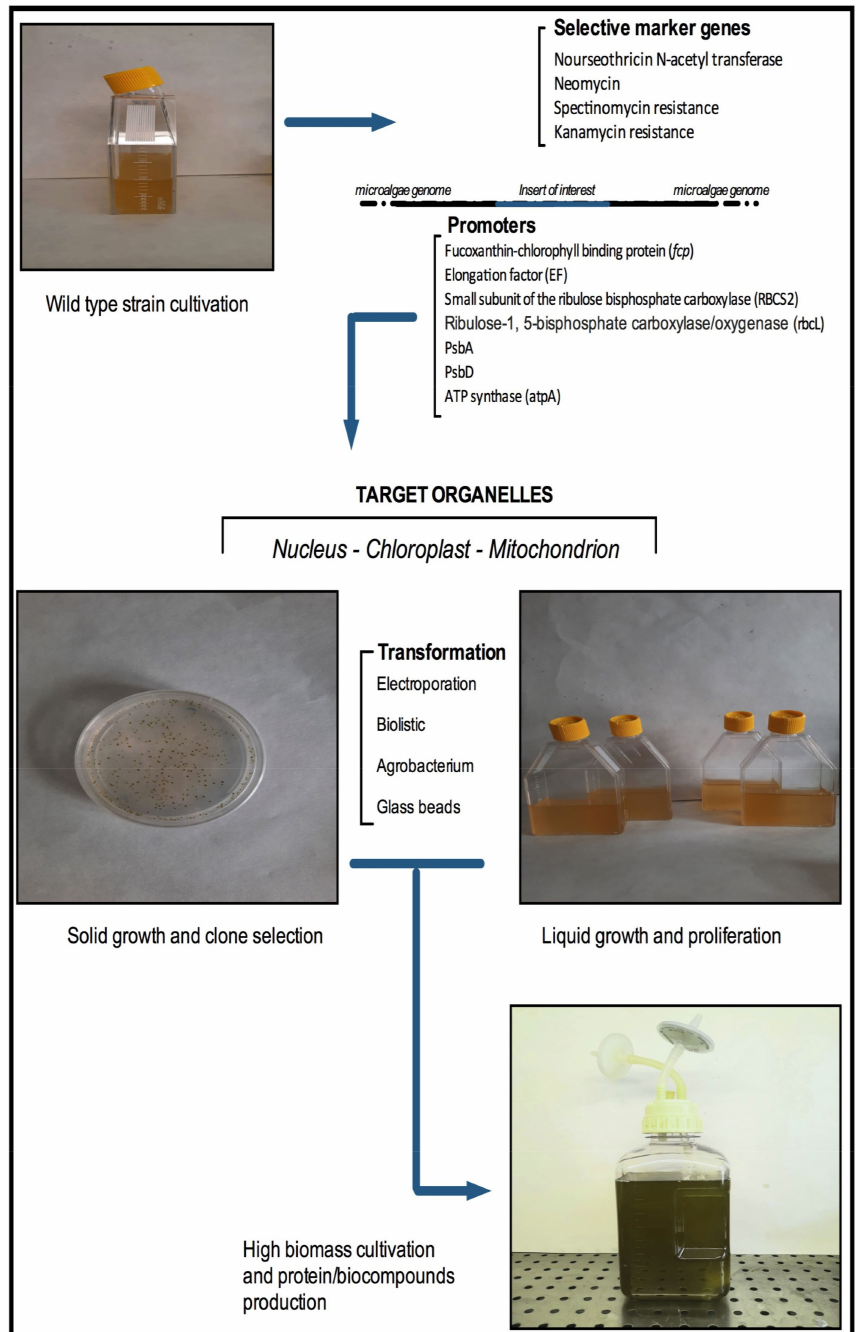
Figure 1. Recognized approaches (Transformation techniques, promoters, selective markers) used to microalgae genetic